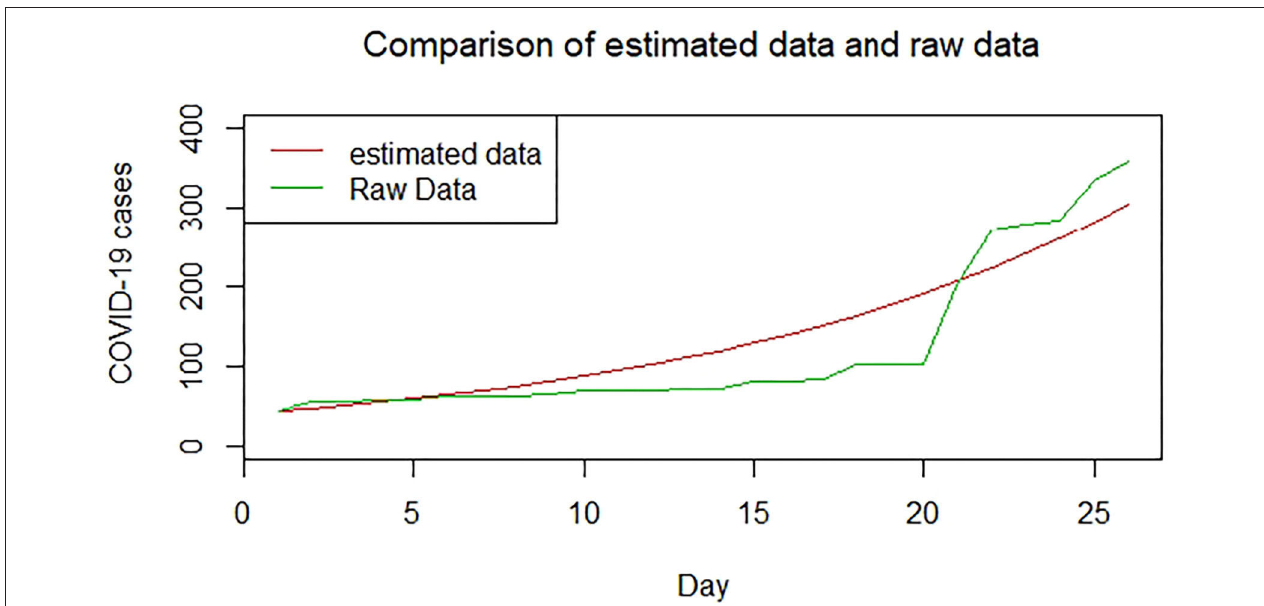
FIGURE 23 | Graph for Malawi.